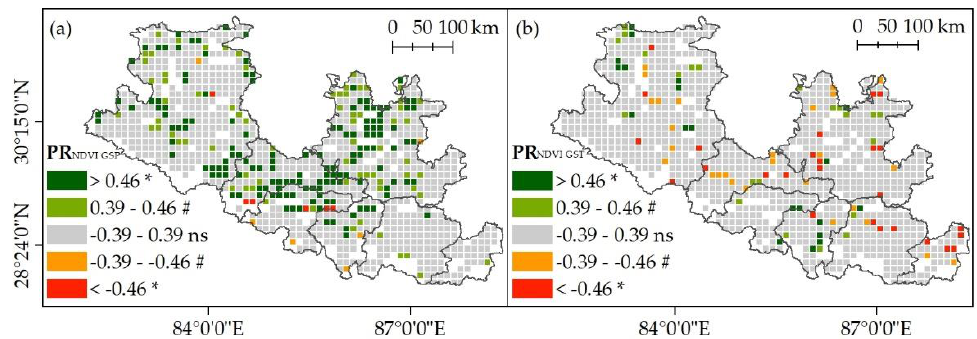
Figure 5. Spatial distribution of the partial correlation coefficients between NDVI and ( a ) GSP, and ( b ) GST. Different colors indicate the classes of partial correlation coefficients. Different symbols denote significant levels: * p < 0.05; # 0.05 < p < 0.10; ns, not significant. The map was created using ESRI ArcMap 10.7 software; the topographic base of the map was created with National Catalogue Service For Geographic Information data (https://www.webmap.cn, figure number: GS(2016)2556).